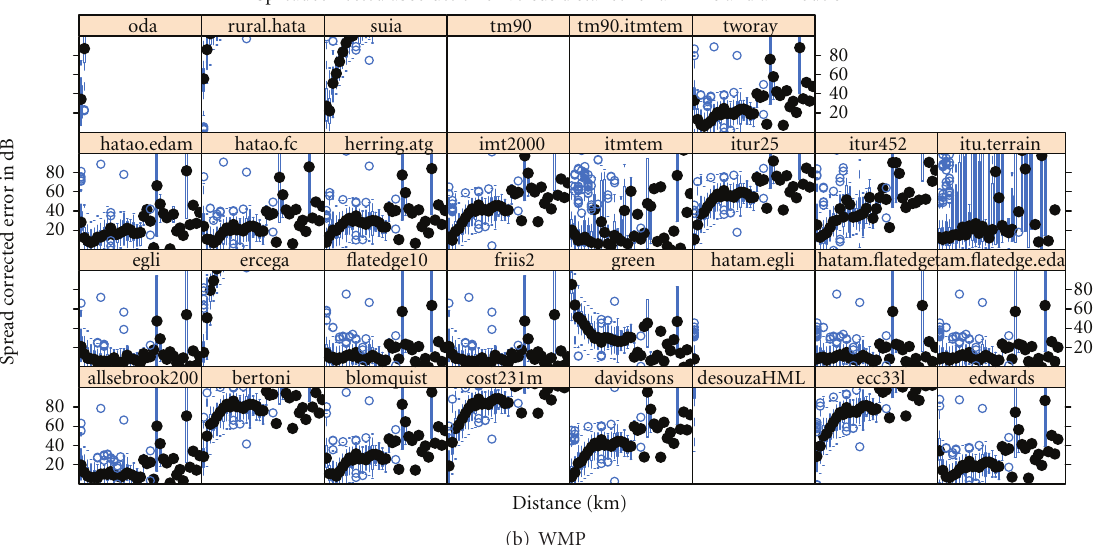
absolute error versus distance for all links and all models